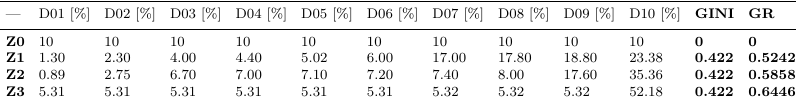
Table 1. The values of the GINI concentration index and the G R index for the structures ( Z 0 ÷ Z 3) showing the distribution of income, where: D01 , ..., D10 are the names of the